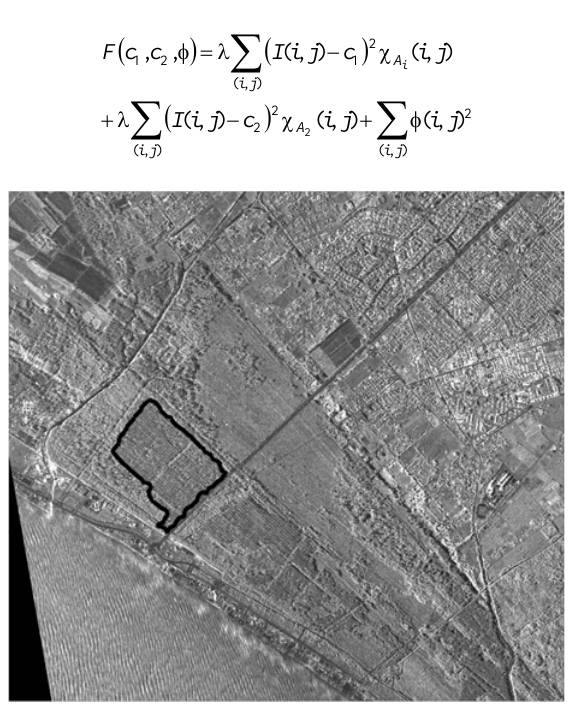
Figure 6. Contour of the canopy subregion in the Castel Fusano